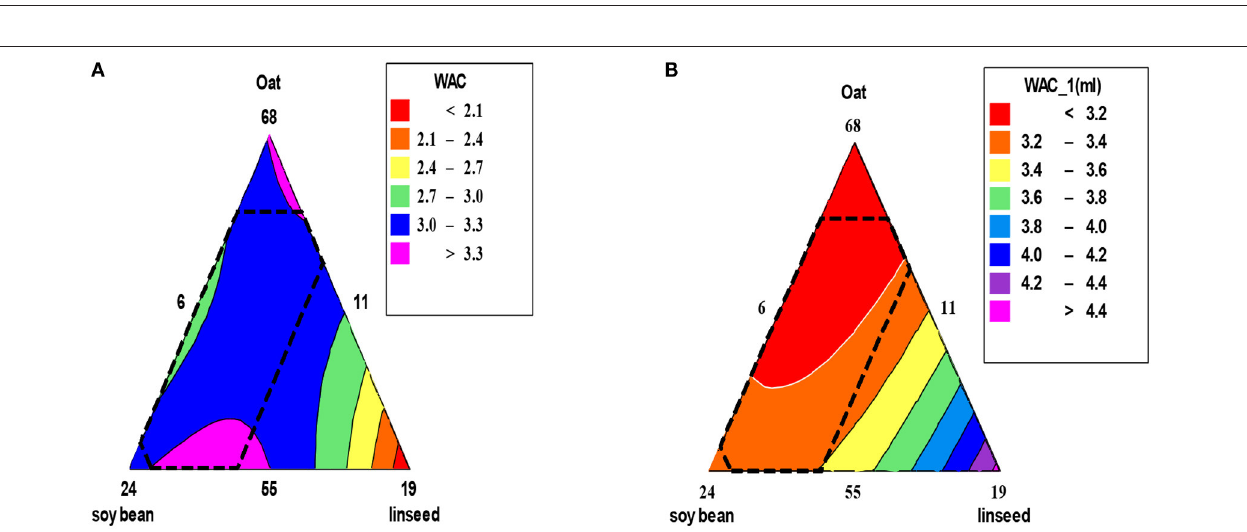
FIGURE 4 | Contour plot of bulk density (g/ml) of extruded (A) and unextruded (B) composite flour.